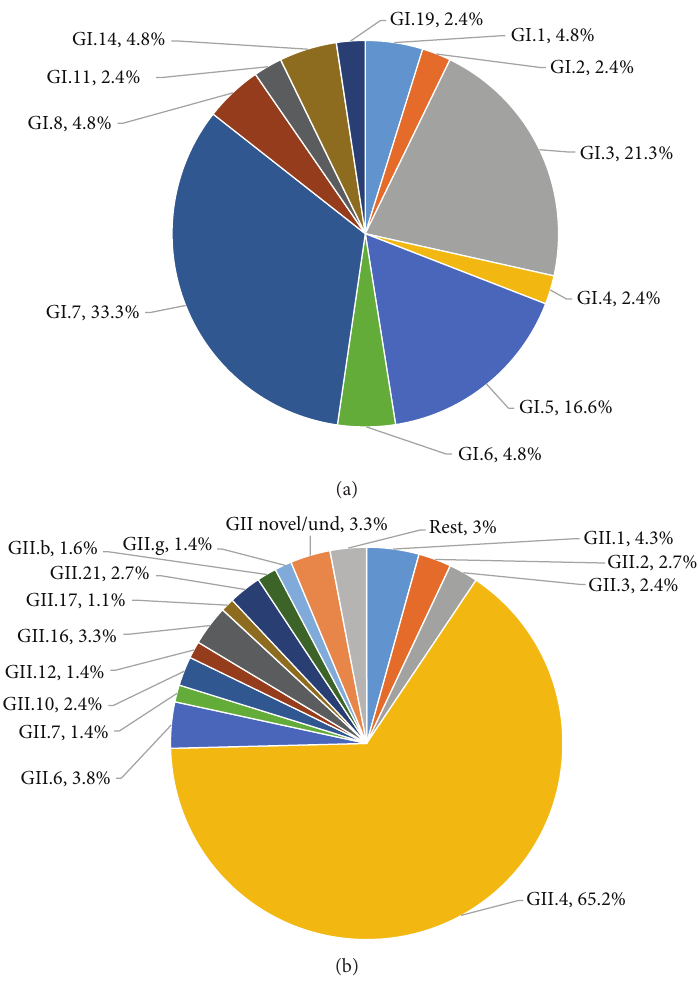
Figure 2: Distribution of GI and GII norovirus genotypes (capsid and polymerase combined) in Sub-Saharan Africa. (a) Relative frequencies of GI genotypes among a total of 42 GI norovirus positive samples from nine studies. GI.7 and GI.3 norovirus infections were more common than any other GI genotype. (b) Relative frequencies of GII genotypes among a total of 368 GII norovirus positive samples from nine studies. GII.4 (65.2%) was the most prevalent genotype. Und: undefined. Rest: GII.e, GII.8, GII.11, GII.13, GII.14, and